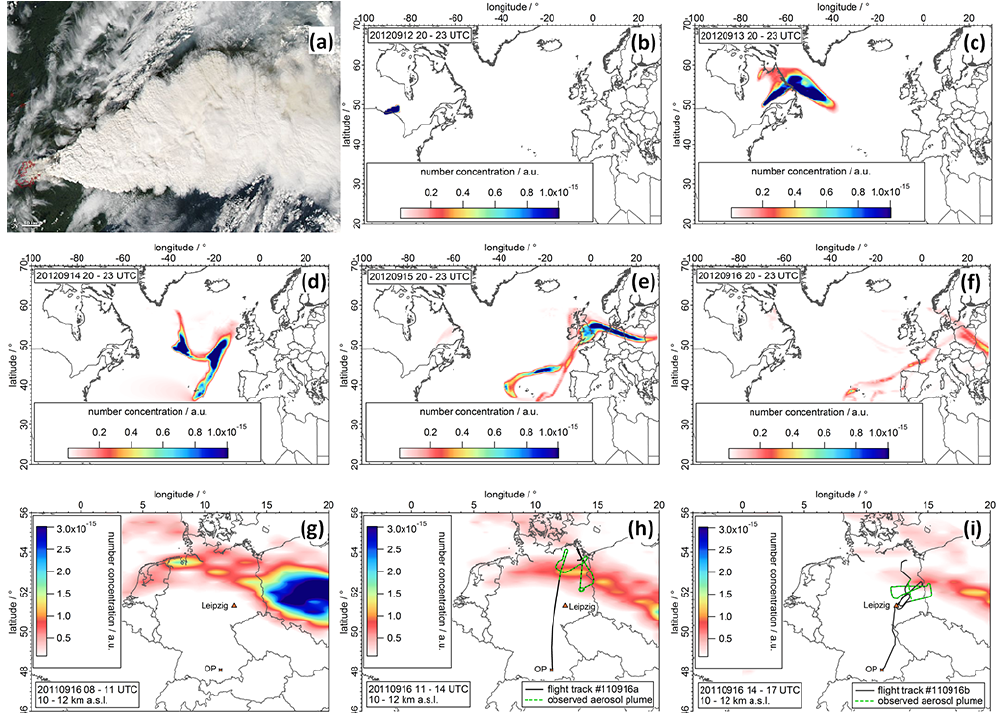
Figure 10. Evolution and dispersion of the Pagami Creek fire plume calculated with HYSPLIT. (a) MODIS picture of Pagami Creek fire in Minnesota, USA on 12 September 2011, 18:50UTC (NASA images courtesy Jeff Schmaltz, MODIS Rapid Response Team at NASA GSFC. Caption by Michon Scott.); (b–f) Daily evolution of the plume vertically integrated from 6–14km from 12 September 2011 through to 16 September 2011 for time period 20–23UTC on each day; (g–i) dispersion of the plume over Germany vertically integrated from 10–12km for the 16 September 2011, (g) : 08:00–11:00UTC, (h) : 11:00–14:00UTC and (i) : 14:00–17:00UTC and locations of Oberpfaffenhofen (OP; star) and Leipzig (triangle). Green dashed lines in (h) and (i) represent the sequences where the Pagami Creek fire plume was